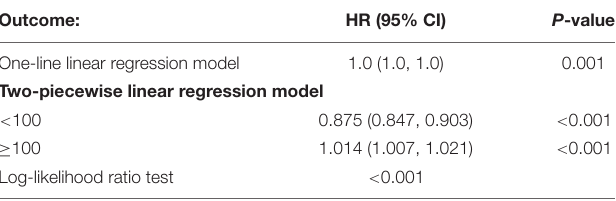
TABLE 4 | Threshold effect analysis for the relationship between Platelet Count and 28-day mortality. Outcome: HR (95% CI) P -value One-line linear regression